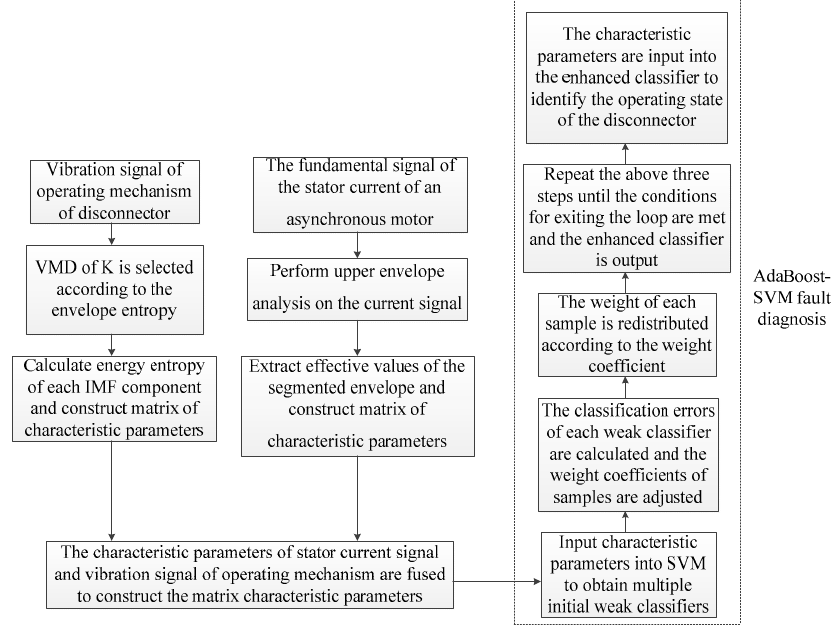
Figure 7. Flow chart of disconnector fault diagnosis.